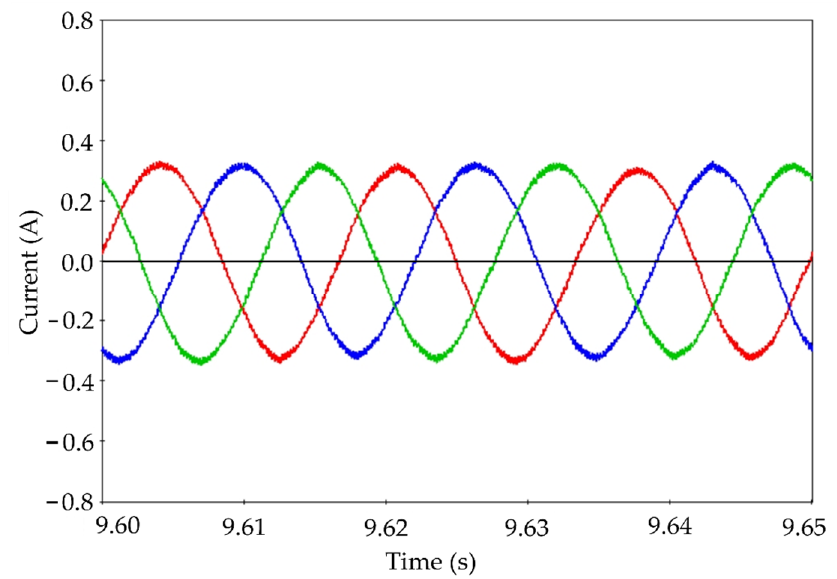
Figure 9. Micro inverter output current waveform for the PQ control simulation case.